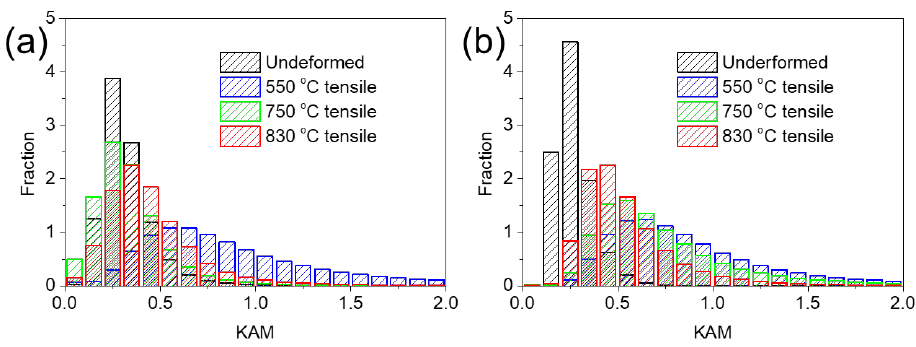
Figure 8. Frequency distribution histograms of the KAM values of SL ( a ) and SH ( b ). SE images and element distribution maps from the view of a cross-section from both specimens are shown in Figure 9. Cracks generation and propagation can be clearly seen from Figure 9a,c, and the length of cracks in SL were much longer compared to that in SH. In order to evaluate the environmental effect to the deformation behavior at a high temperature, distributions of O, Ni, and Al were detected by EDS around cracks. An enrichment of O along cracks can be seen from Figure 9b,d.